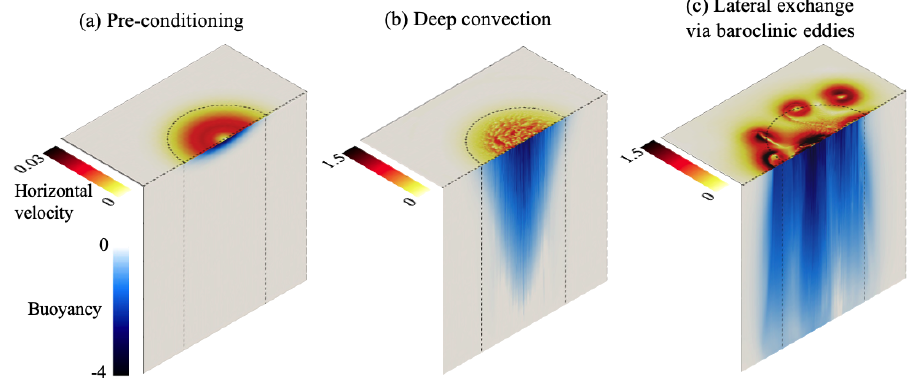
Figure 3. Fine-scale simulations show the three different stages of open-ocean convection. A background stratification is imposed on the initial buoyancy profile to model the ocean stratification. The dotted lines outline the horizontal extent of the destabilizing buoyancy imposed at the top surface. Colored panels show the normalized horizontal velocity (speed) and buoyancy. Note that the domain height has been stretched to more clearly show the convection dynamics, the domain height-to-width ratio is 0.025. The non-dimensionalized simulations have governing parameters which were chosen to ensure that the simulations were in the same dynamical regime expected for the ocean. Image adapted from simulations by Sohail et al. [70] and we refer the reader to this paper for further